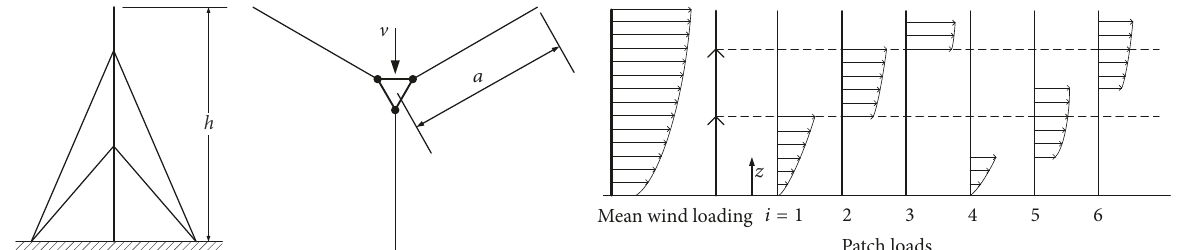
Figure 1: Typical mast with two clusters of guys. Horizontal plan of the mast.